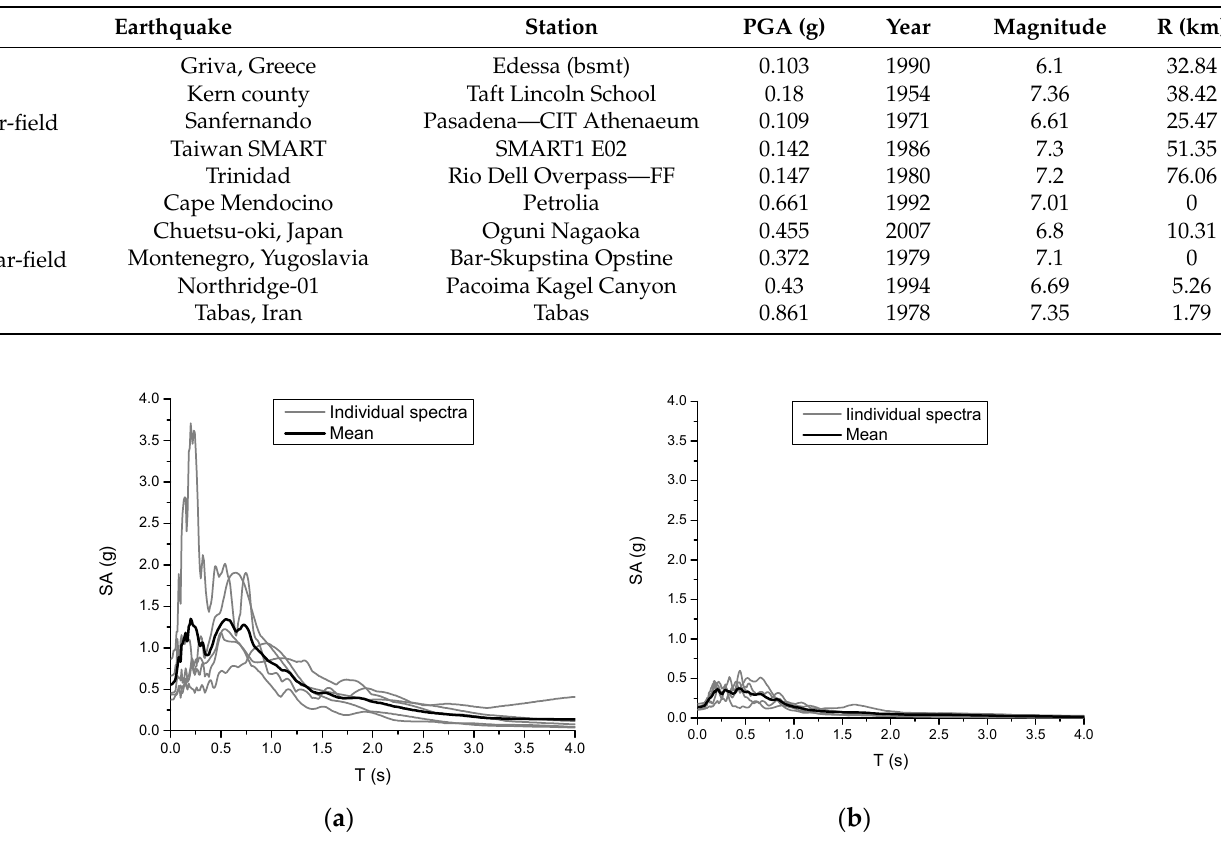
Figure 2. Ground motion response spectra, ( a ) near-field, ( b ) far-field. Table 2. Ground motion parameters of selected earthquakes. In order to cover an appropriate range for IM, ground accelerations ranging from 0.1 g to 1 g were Earthquake